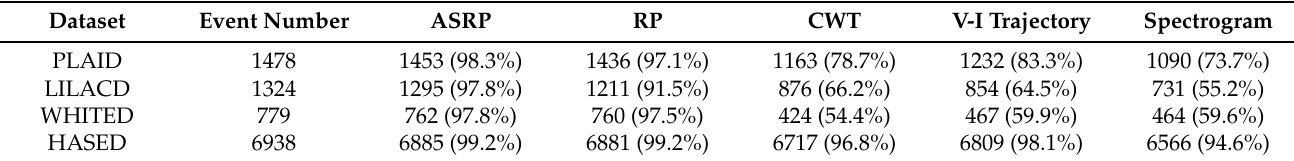
Figure 11. Comparison of RP and ASRP feature display effects. ( a ) RP and ASRP of WK. ( b ) RP and ASRP of CM. Table 3. Number of successful identifications of load events in each dataset (Event number is the total number of events for each type of load in each dataset. ASRP, RP, CWT, V-I trajectory, Spectrogram are the number of events accurately identified after the corresponding feature extraction method is